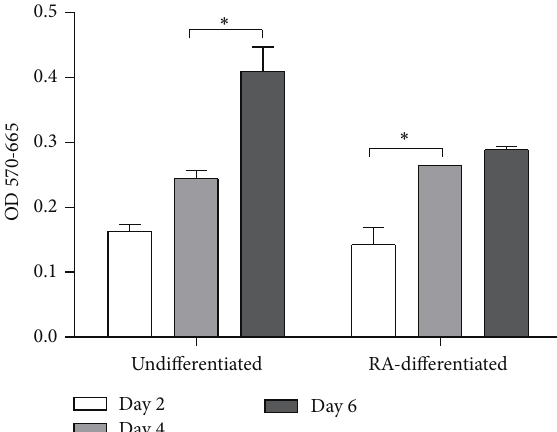
Figure 1: The proliferation of undifferentiated and differentiated SH-SY5Y cells. Cells were differentiated in 10 𝜇 M retinoic acid (RA). After differentiation for 2, 4, and 6 days, cell proliferation was assessed using MTT assay. Absorbance at 570 nm with 665 nm as a reference was measured, and differences between the two absorbances were analyzed. Data are expressed as mean ± SD from three replicate wells. ∗ 𝑃 < 0.05